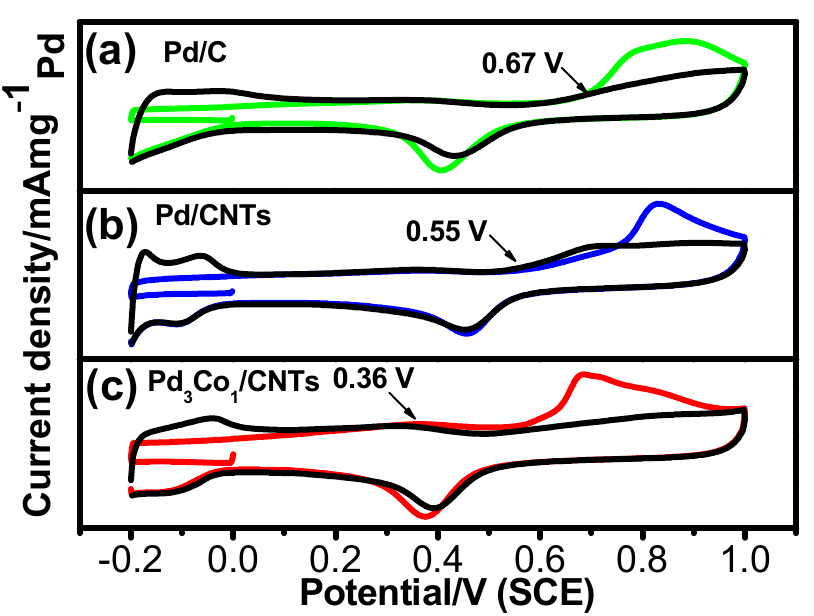
Figure 5. CO stripping voltammograms of Pd/C, Pd/CNT and Pd 3 Co 1 /CNT catalysts in 0.5 M H 2 SO 4 solution.